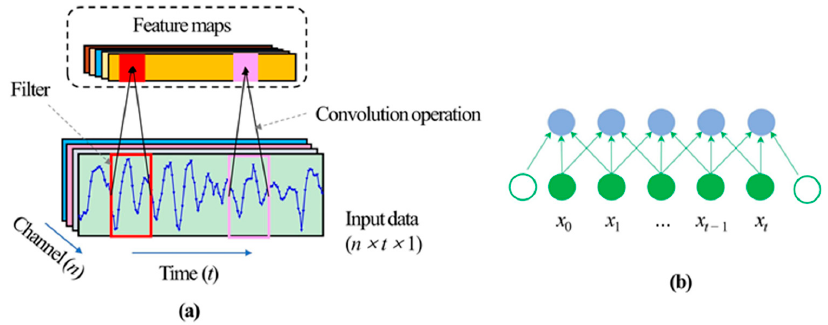
Figure 1. ( a ) The 1D-CNN model structure. ( b ) The convolution operation with kernel size k = 3.